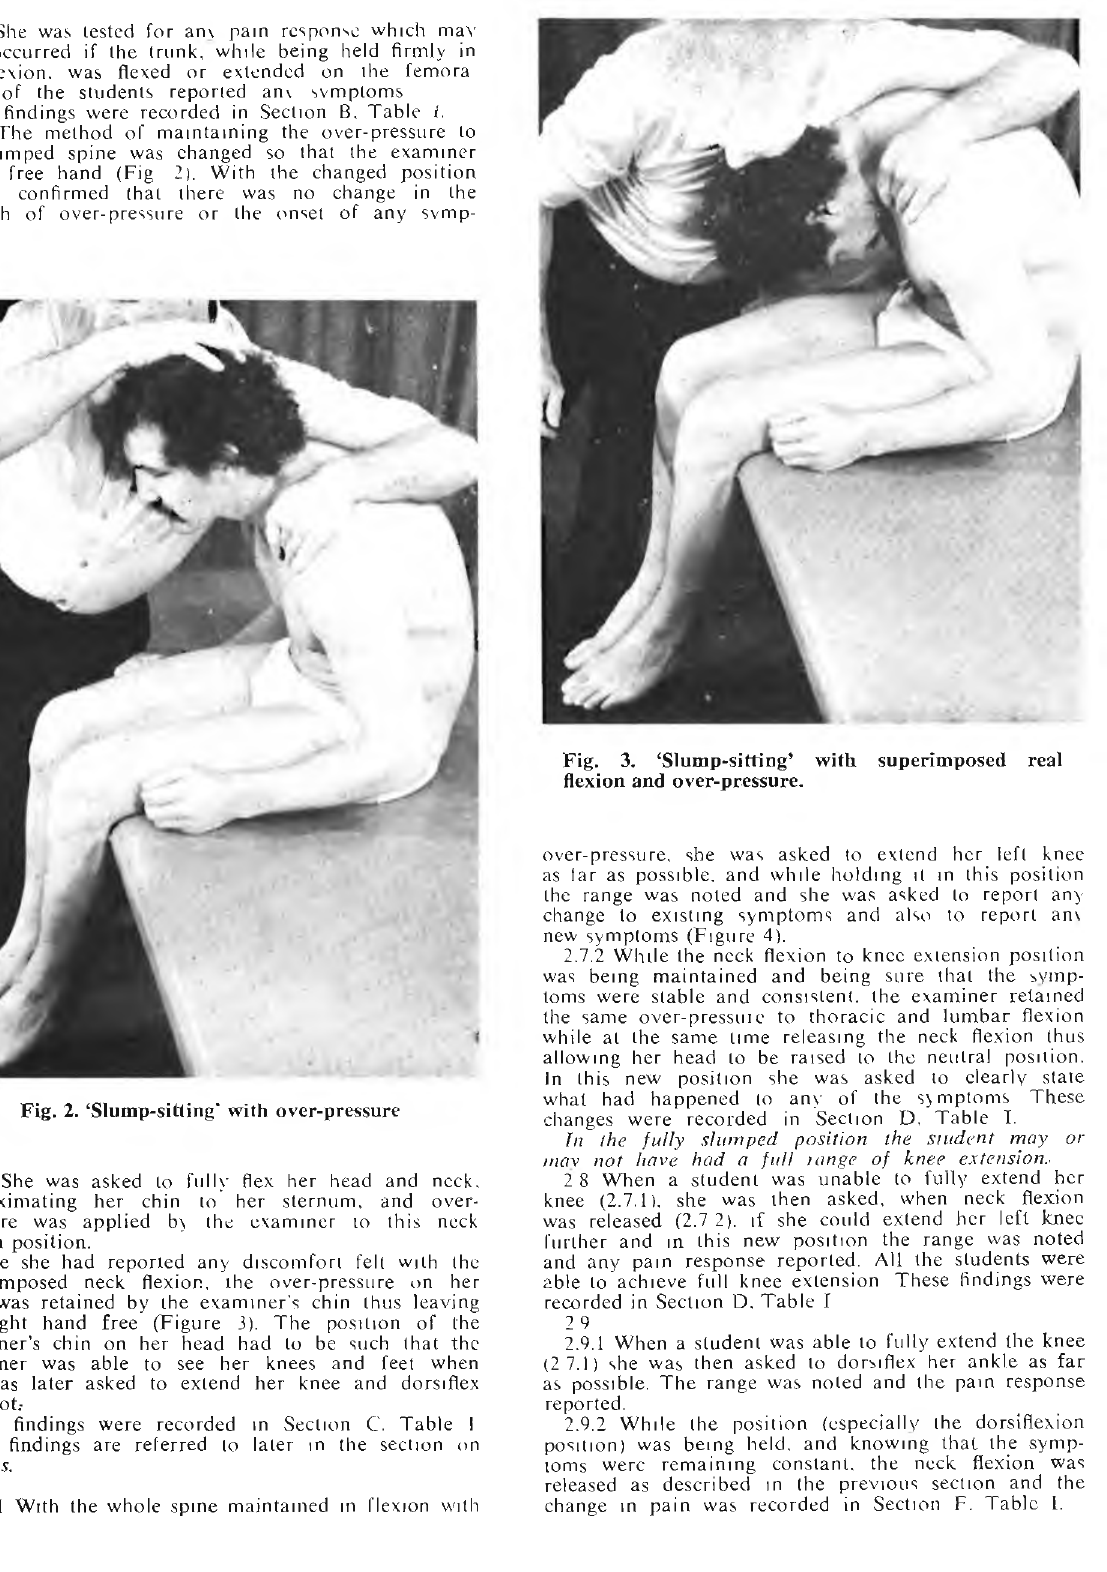
Fig. 2. ‘Slump-sitting' with over-pressure